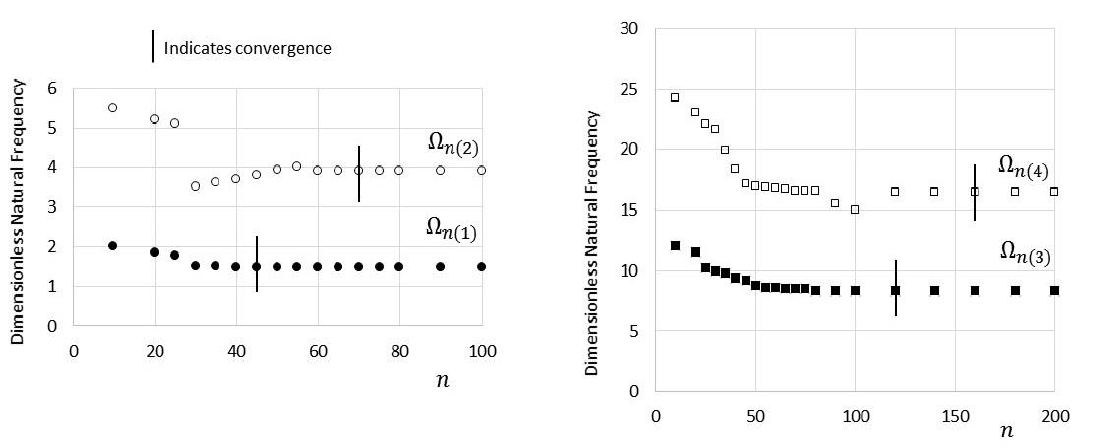
Figure 4. Convergence plots for the first two dimensionless natural frequencies (nonrotating).